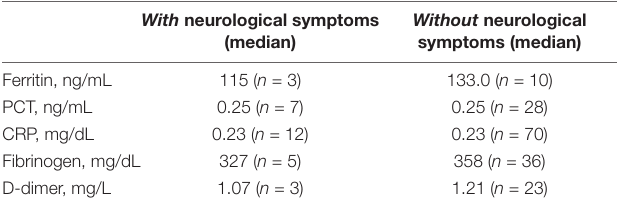
TABLE 3 | Comparison of inflammatory markers between patients with and without neurological symptoms. With neurological symptoms (median)